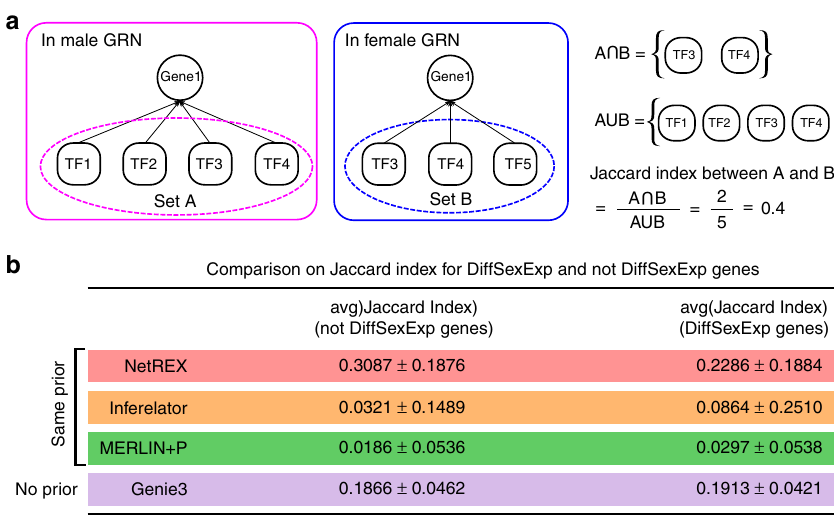
Fig. 5 Evaluation of similarities of female and male GRNs. a Illustration of the method to compute the similarity of regulatory program in female and male GRNs for a fi xed gene (Jaccard index). b Testing the similarity of the inferred regulatory programs in female and male GRN using all predicted edges. DiffSexExp genes are de fi ned using independent data (details in Supplementary Note 4). The spread of the Jaccard indexes is their standard